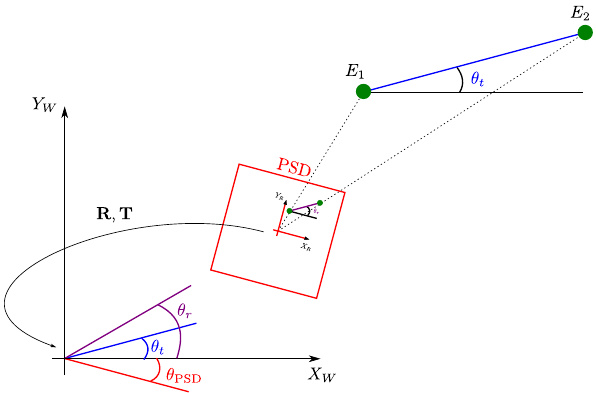
Figure 4. Method for obtaining the angle θ PSD